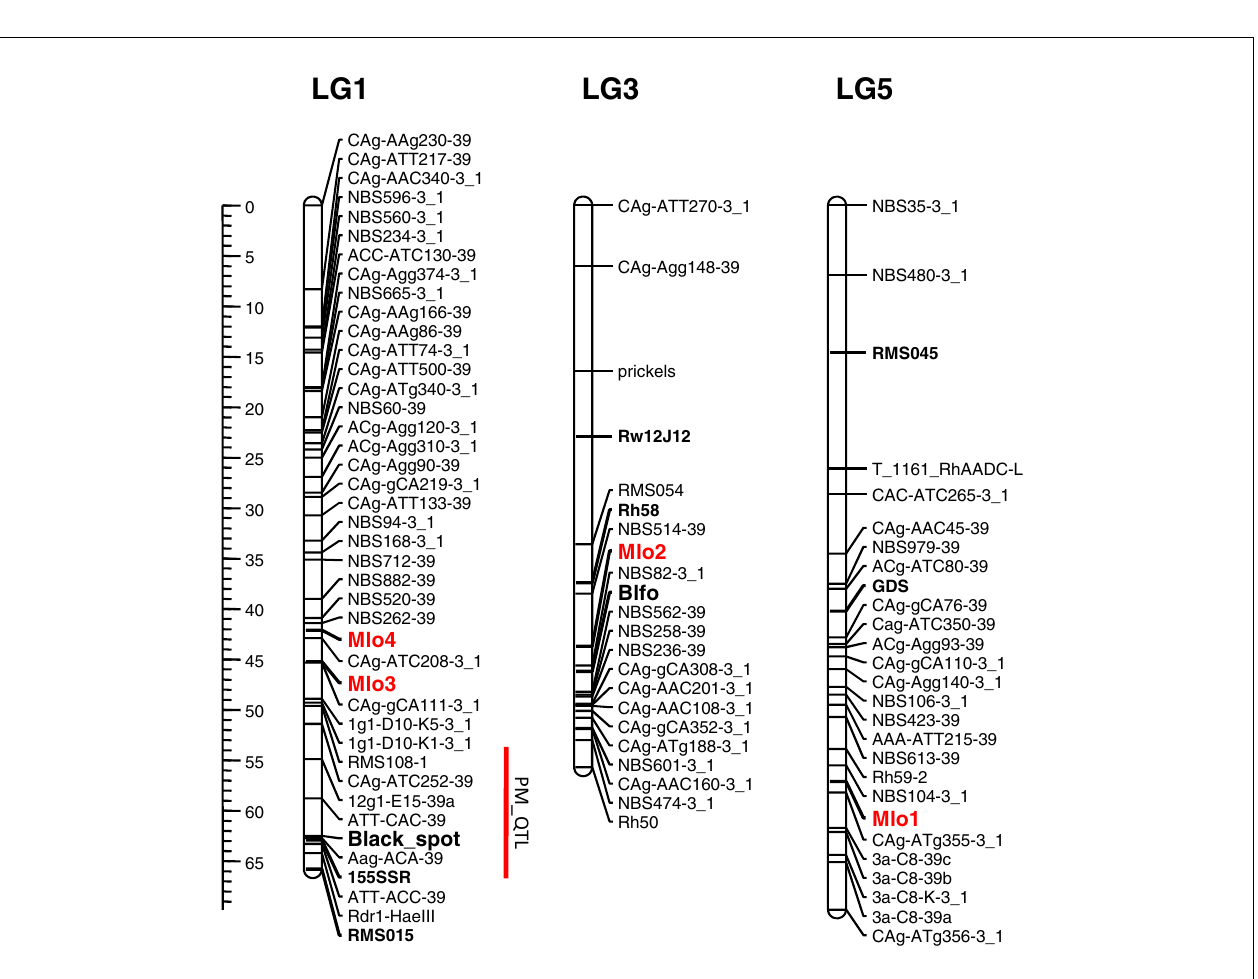
FIGURE 4 | Genetic linkage map of the linkage groups 1, 3, and 5 harboring the MLO genes. The linkage groups of the parent 95/13-39 of the population 97/7 are shown. Map distances are given using cM as a ruler.The bridge markers that have been mapped in other rose populations (Spiller